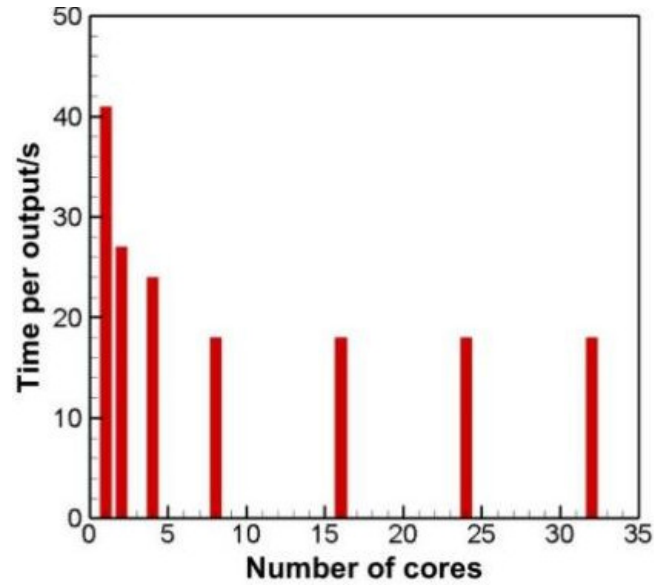
Figure 5. Efficiency of the parallel algorithm.